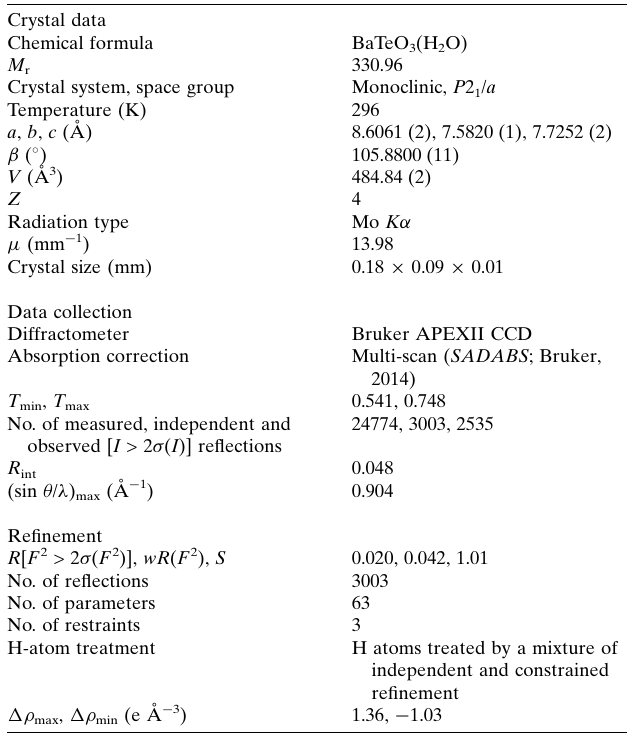
Table 3 Experimental details.